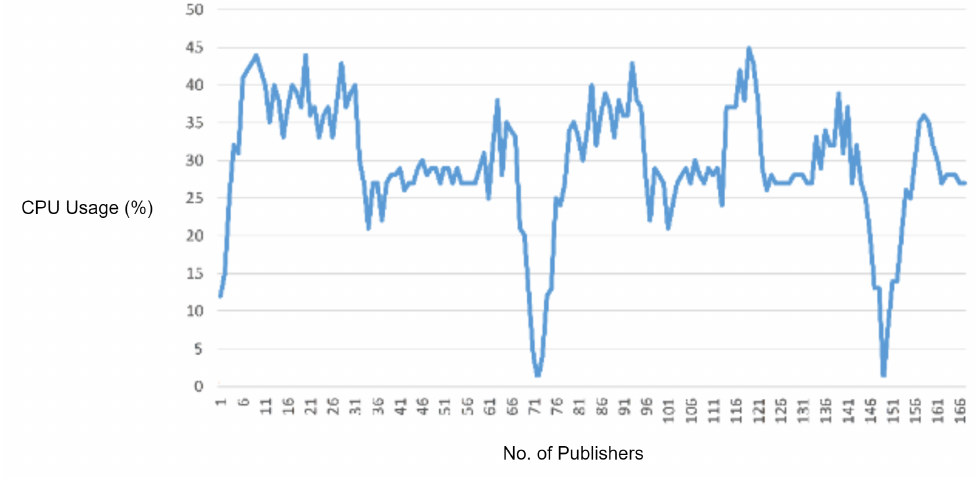
Figure 10. CPU usage captured while testing the improper length check